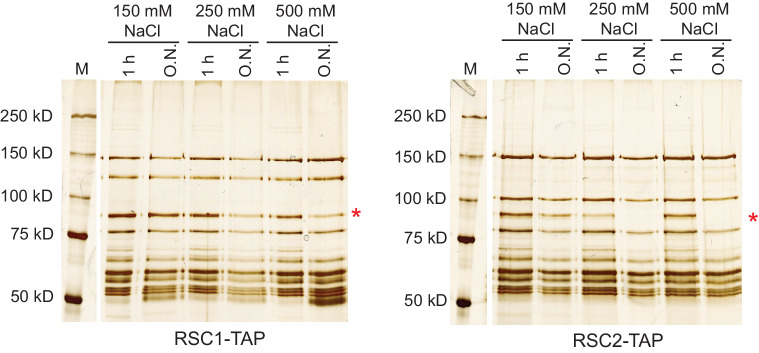
The Rsc3/30 module associates with the RSC1 complex at high stringency.Yeast cell lysates containing RSC-TAP complexes were bound to IgG resin, the beads rinsed with lysis buffer before washing with buffer of the indicated salt concentration and duration. RSC complexes were analyzed on 6% acrylamide SDS-PAGE gels stained with silver. The Rsc3 and Rsc30 proteins run closely on denaturing gels and the doublet will often appear as a single band, marked by the asterisk (*). The marker lanes (M) are each from the adjacent gel, but were moved for depiction. Stringency testing conducted once.